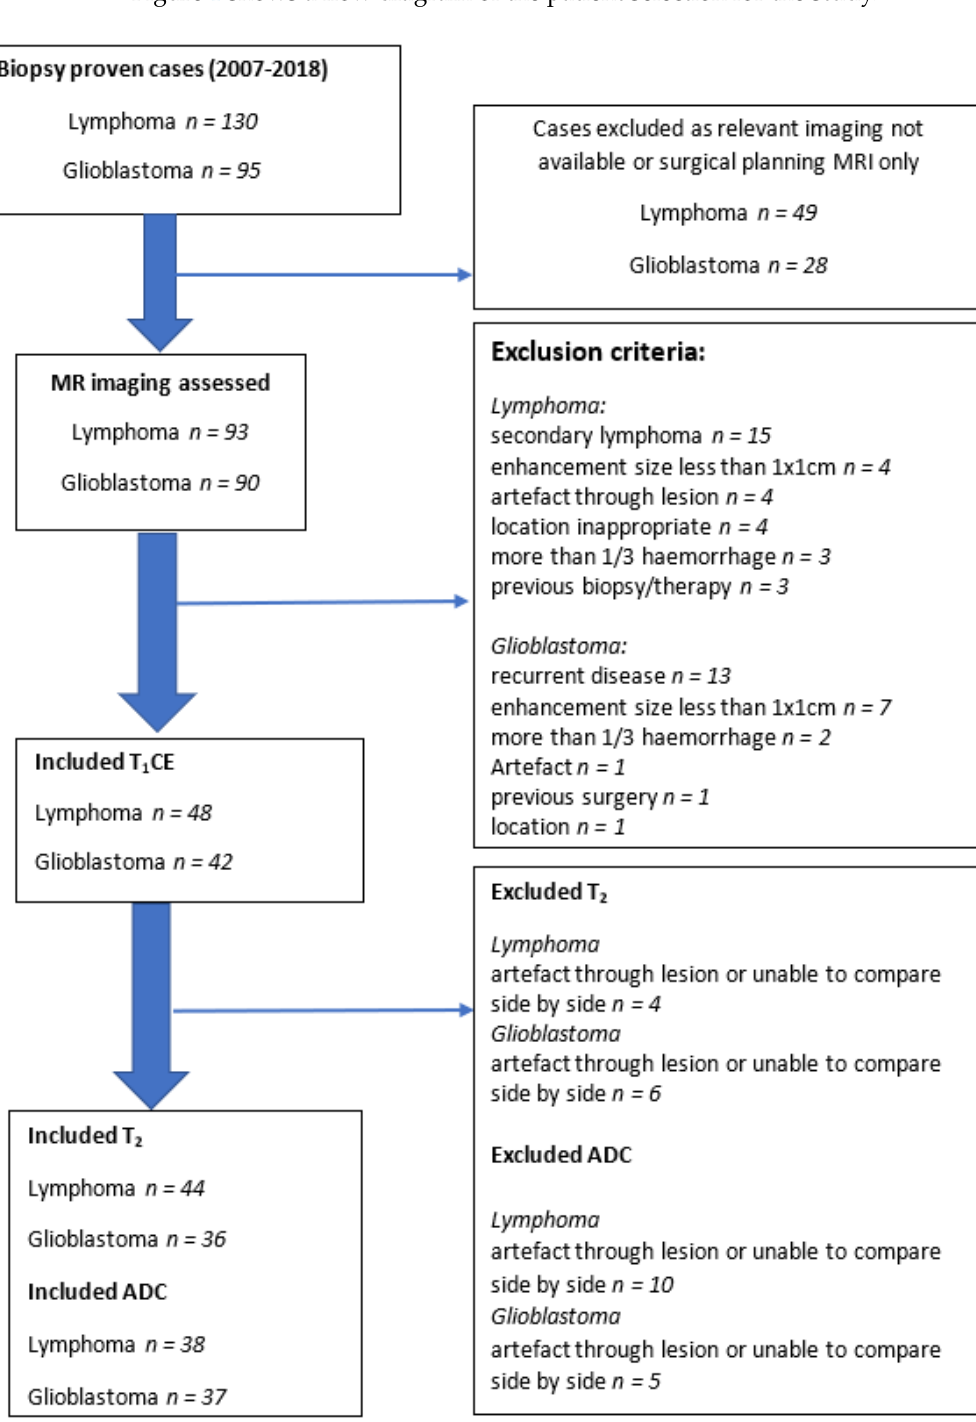
Figure 1. Flow diagram showing patient exclusion and inclusion criteria.